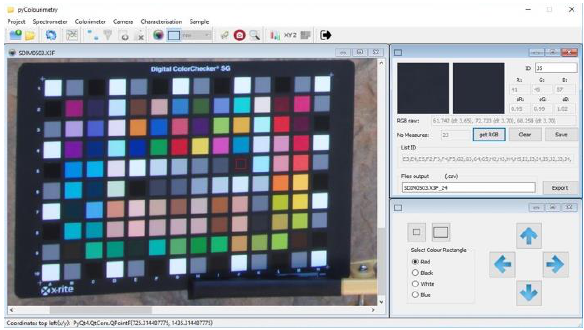
Figure 4. Measuring RGB data with pyColourimetry software